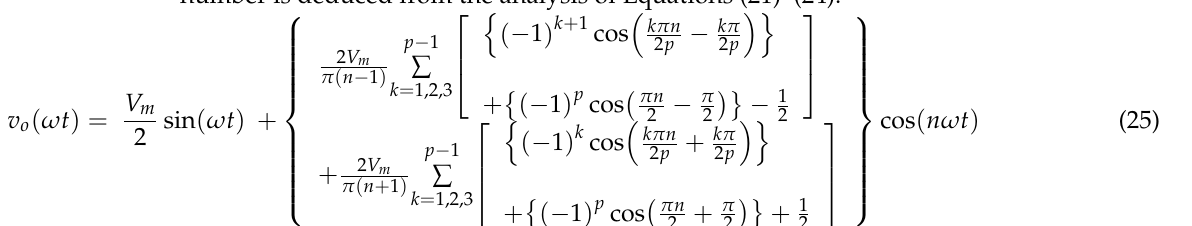
Figure 5. Output RMS voltage control through the pulse-width modulation (PWM) control. The following generalized form of the instantaneous output voltage for any pulse number is deduced from the analysis of Equations (21)–(24).